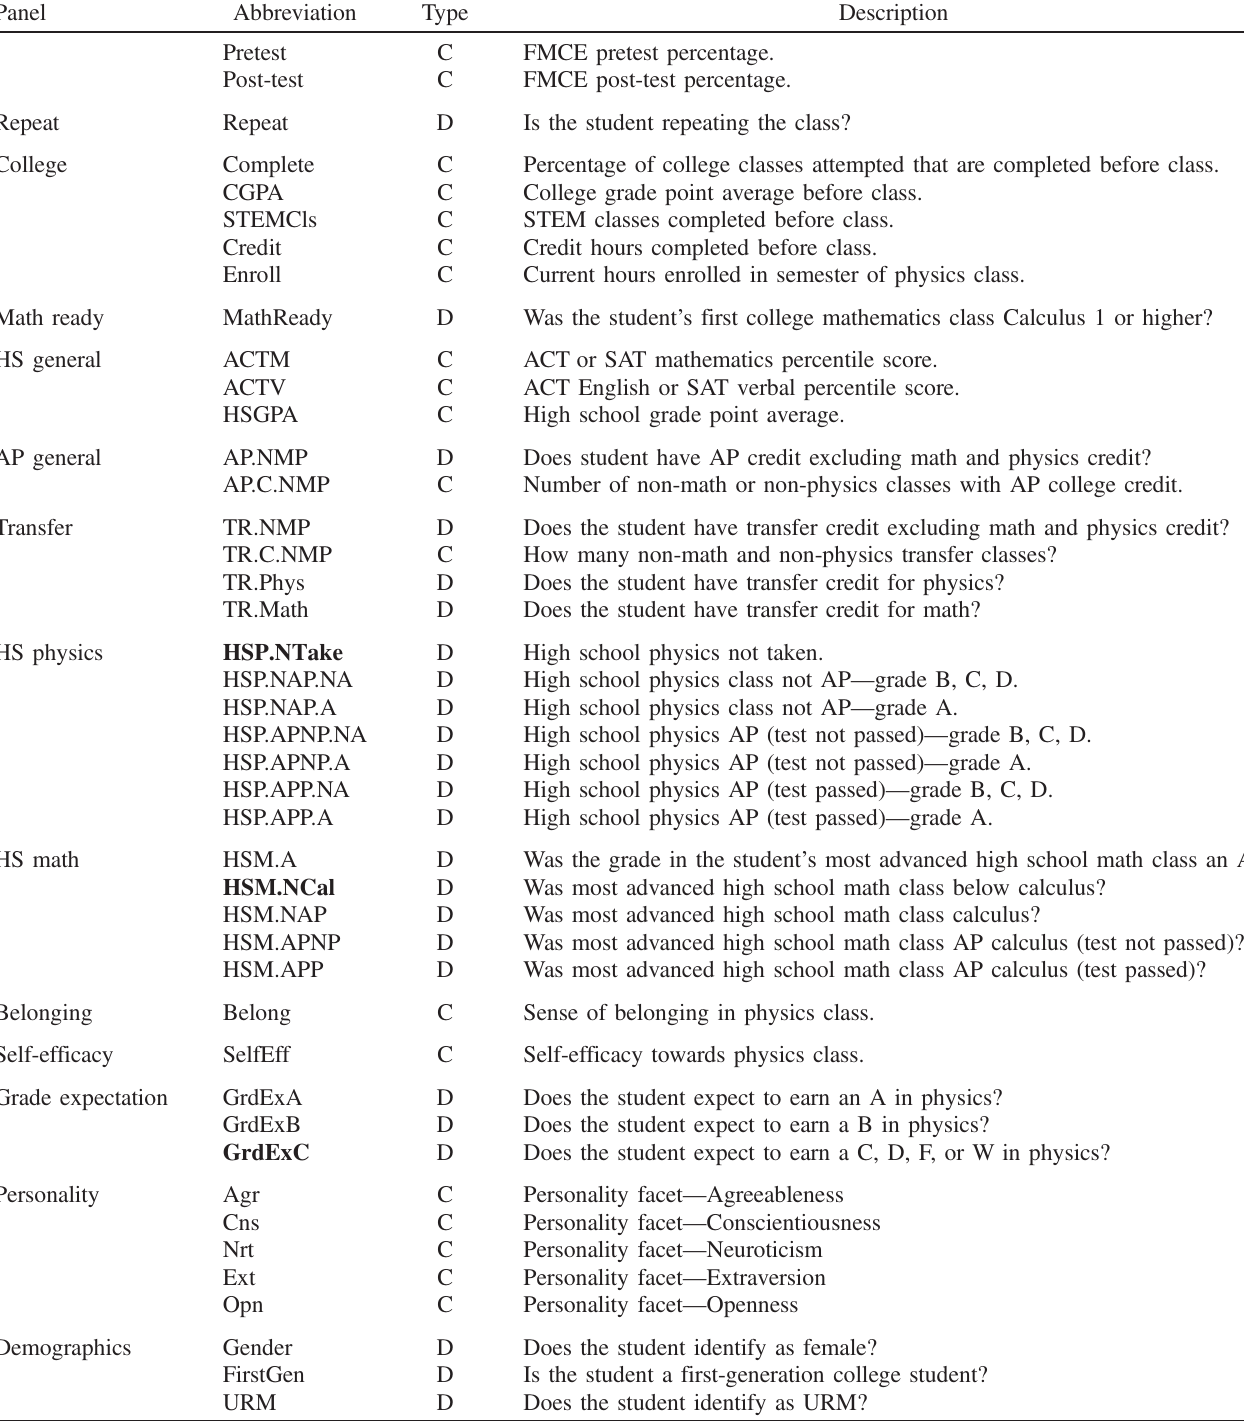
TABLE I. List of variables. Type indicates whether the variable is continuous (C) or dichotomous (D). The base level variable for each dummy-coded multilevel variable is indicated by bold